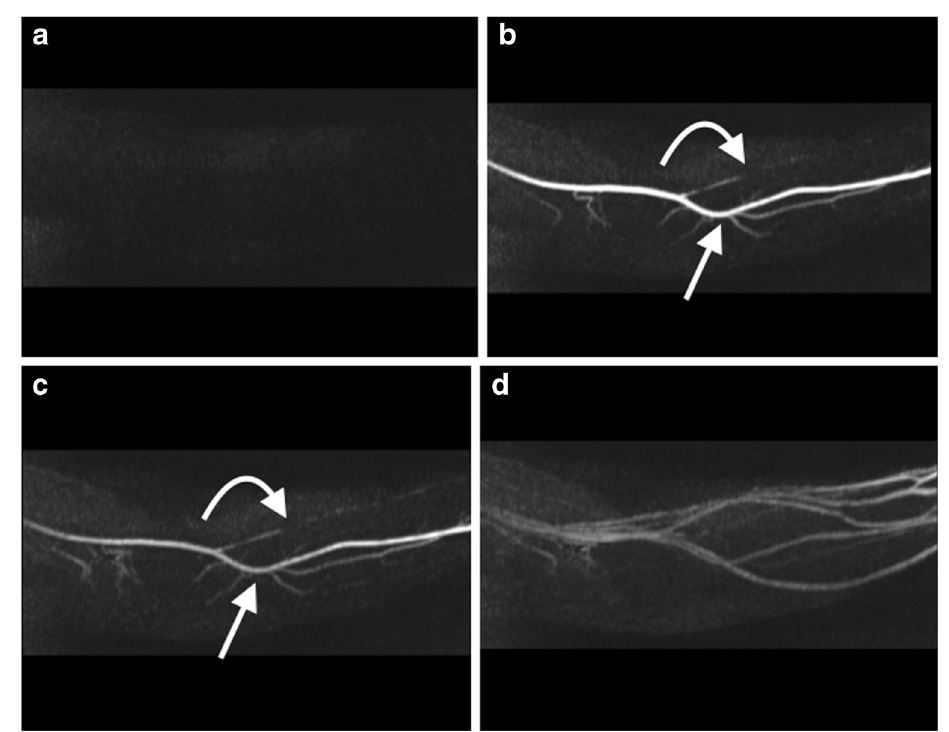
Fig. 16 A 45-year-old man with a previous history of left radial ar- tery thrombosis post coeliac ar- tery stenting with persistent arm claudication. Time resolved MRA ( a-d ) of the left forearm demon- strates opacification of the left brachial artery, and left ulnar ar- tery ( arrows ) with occlusion of the proximal left radial artery ( curved arrows ) ( b,c ), followed by venous filling ( d